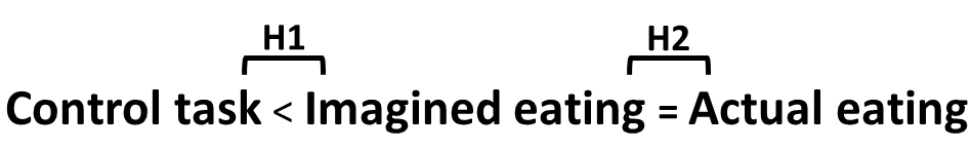
Figure 1. Hypotheses relationship. The figure illustrates how satiation increases from a control task to imagined eating and actual eating. H1 and H2 refer to, respectively, hypotheses 1 and 2, tested in this